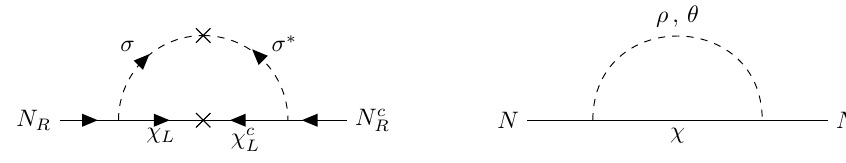
Figure 5 . Radiative generation of m N in Model A2c. On the left, the diagram is drawn in the interaction basis, whereas on the right, in the mass basis. The crosses denote mass insertions µ 2 and m χ